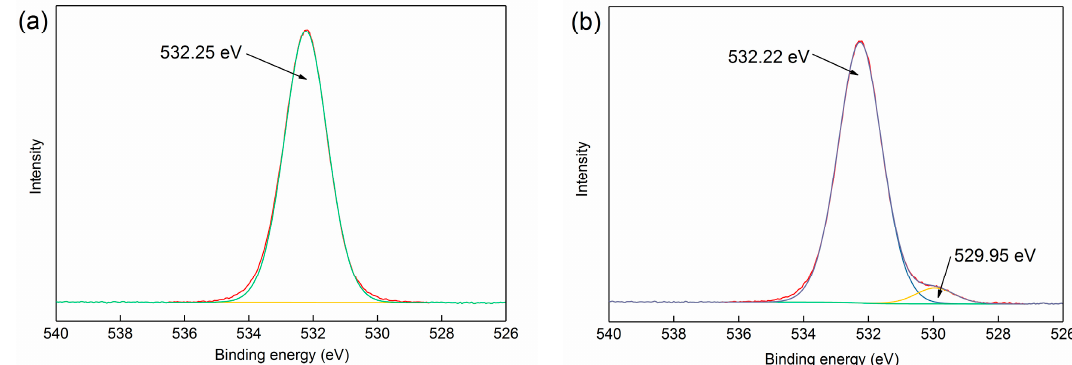
Figure 7. O 1s spectra of ( a ) untreated celestite and ( b ) celestite treated with ferric ions (The red lines are original curves and the green lines are background curves).